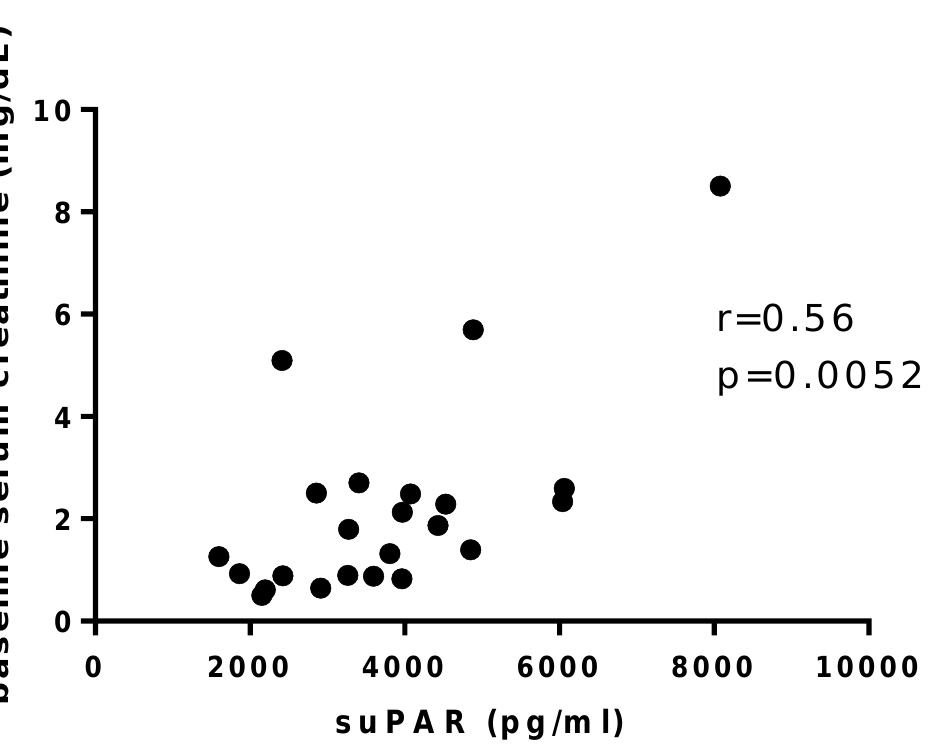
Figure 3. Correlation between serum soluble urokinase plasminogen activator receptor (suPAR) and baseline serum creatinine in Podocitopathy group (suPAR, soluble urokin) .